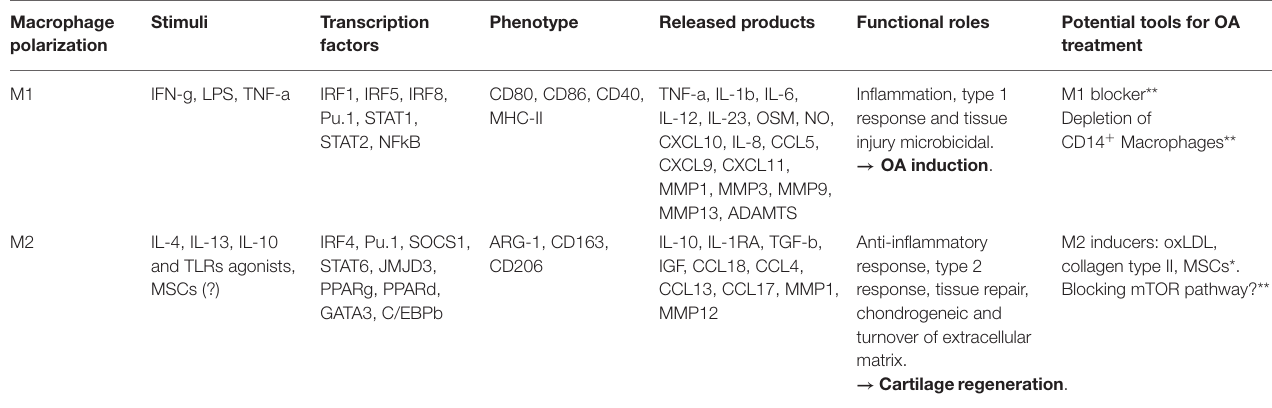
TABLE 1 | Macrophage polarization in OA and cartilage